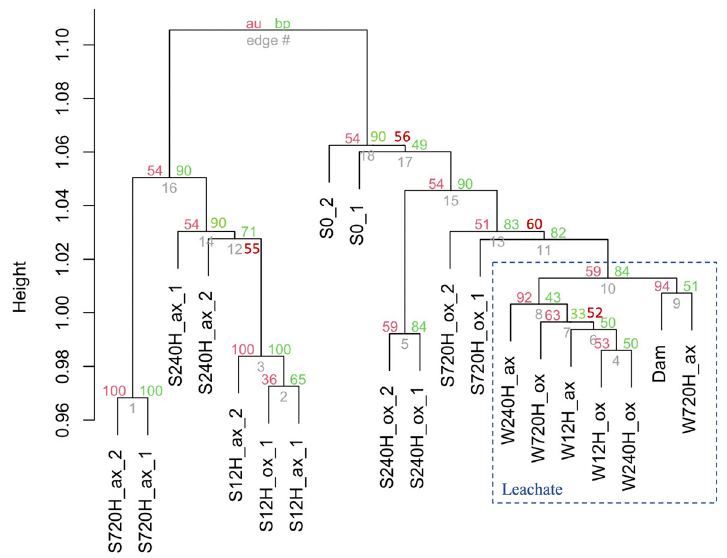
Figure 7. Dendrogram from cluster analysis of bacterial 16S rRNA gene diversity in the oxic (ox), and anoxic (ax) incubations, in the sediment (S) and water (W) samples and for both duplicates (_1 and _2). Bar indicates dissimilarity values. Approximately unbiased (au) p values are shown in red, and bootstrap probability (bp) values are shown in green at each node. S0, initial sediment before incubation; Dam, dam lake water sample.